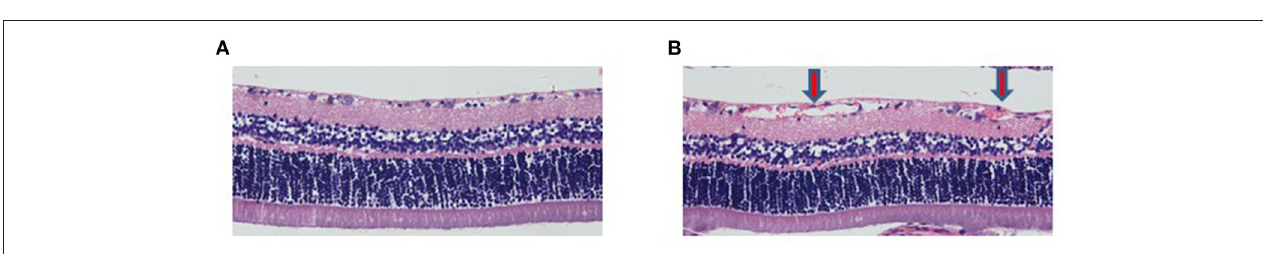
Frontiers in Pediatrics |